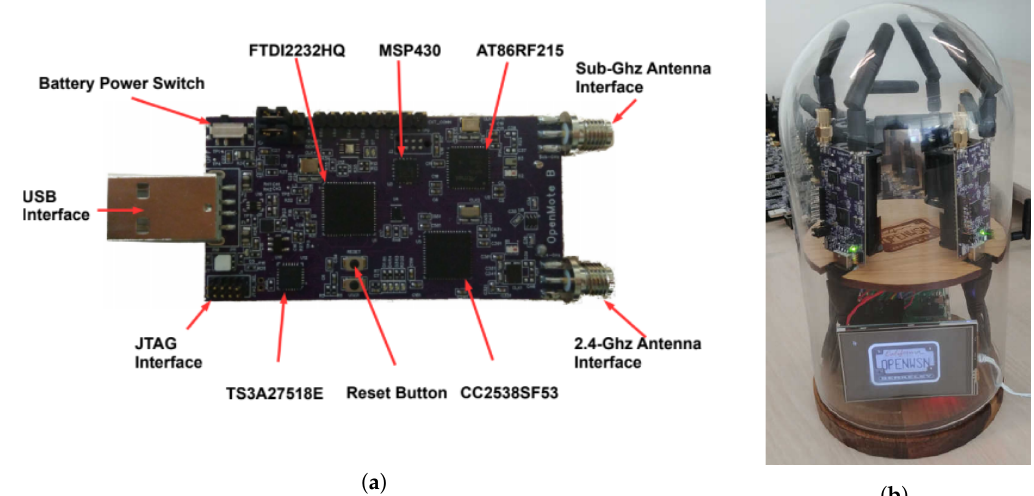
Figure 3. Components of the OpenTestbed experiment setup. ( a ) The OpenMote B, ( b ) the OpenTestbox, part of the